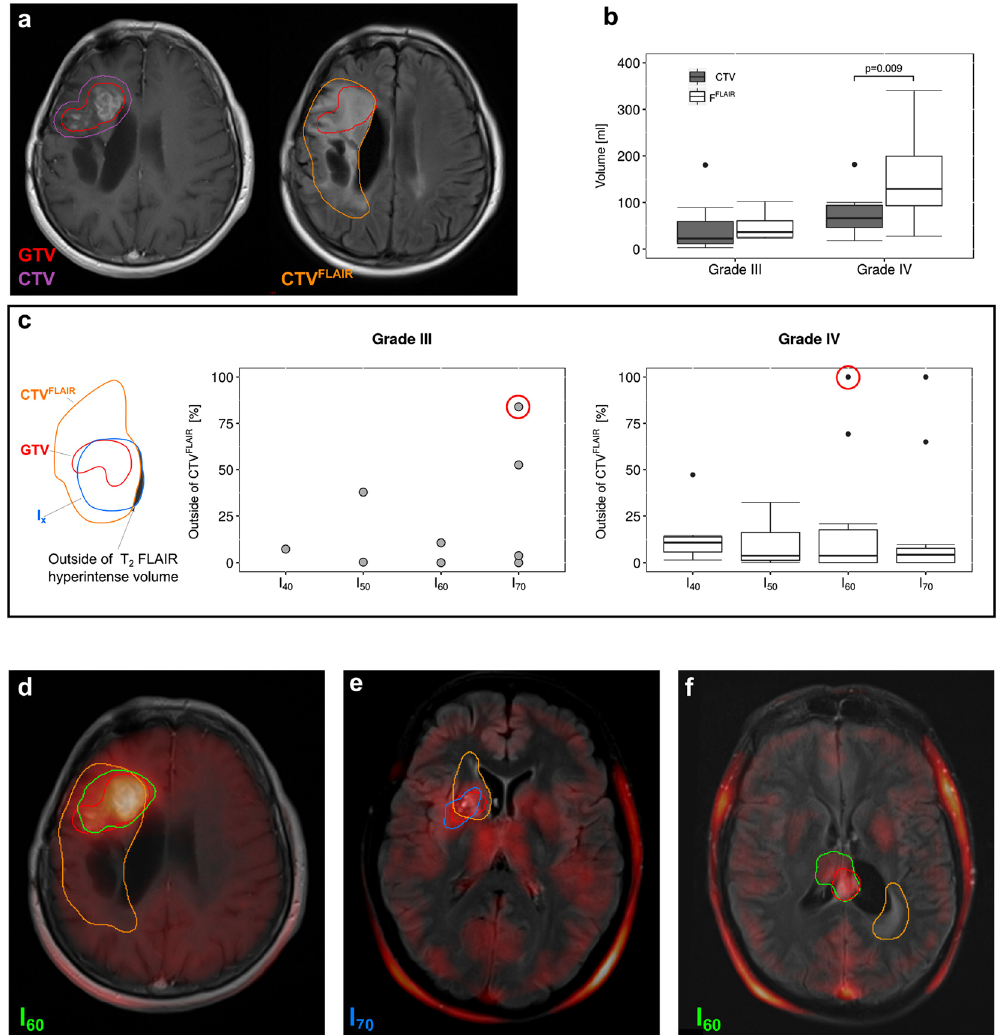
Figure 5. Coverage of 18 F-FET PET isocontour volumes by T 2 FLAIR hyperintense regions. Novel guidelines suggest inclusion of regions that are hyperintense on T 2 FLAIR MRI (orange) into CTV FLAIR ( a ). In grade IV glioma, this significantly increases the volume of CTV ( b ). The fraction of the 18 F-FET PET based isocontour volumes that lies outside of the T 2 FLAIR hyperintense volume, was calculated ( c ). With two exceptions for isocontours of 70% in grade III tumors and three exceptions for isocontours of either 60% or 70% in grade IV tumors, more than 80% of the isocontours were covered by the T 2 FLAIR hyperintense volume ( c ). Representative patient with grade IV glioma where over 90% of the 18 F-FET PET active area lies within CTV FLAIR ( d ). Exemplary cases of two exceptional patients circled in red in the boxplots ( c ) with large fractions of the isocontour volumes (70% and 60%) laying outside the T 2 FLAIR hyperintense volume are